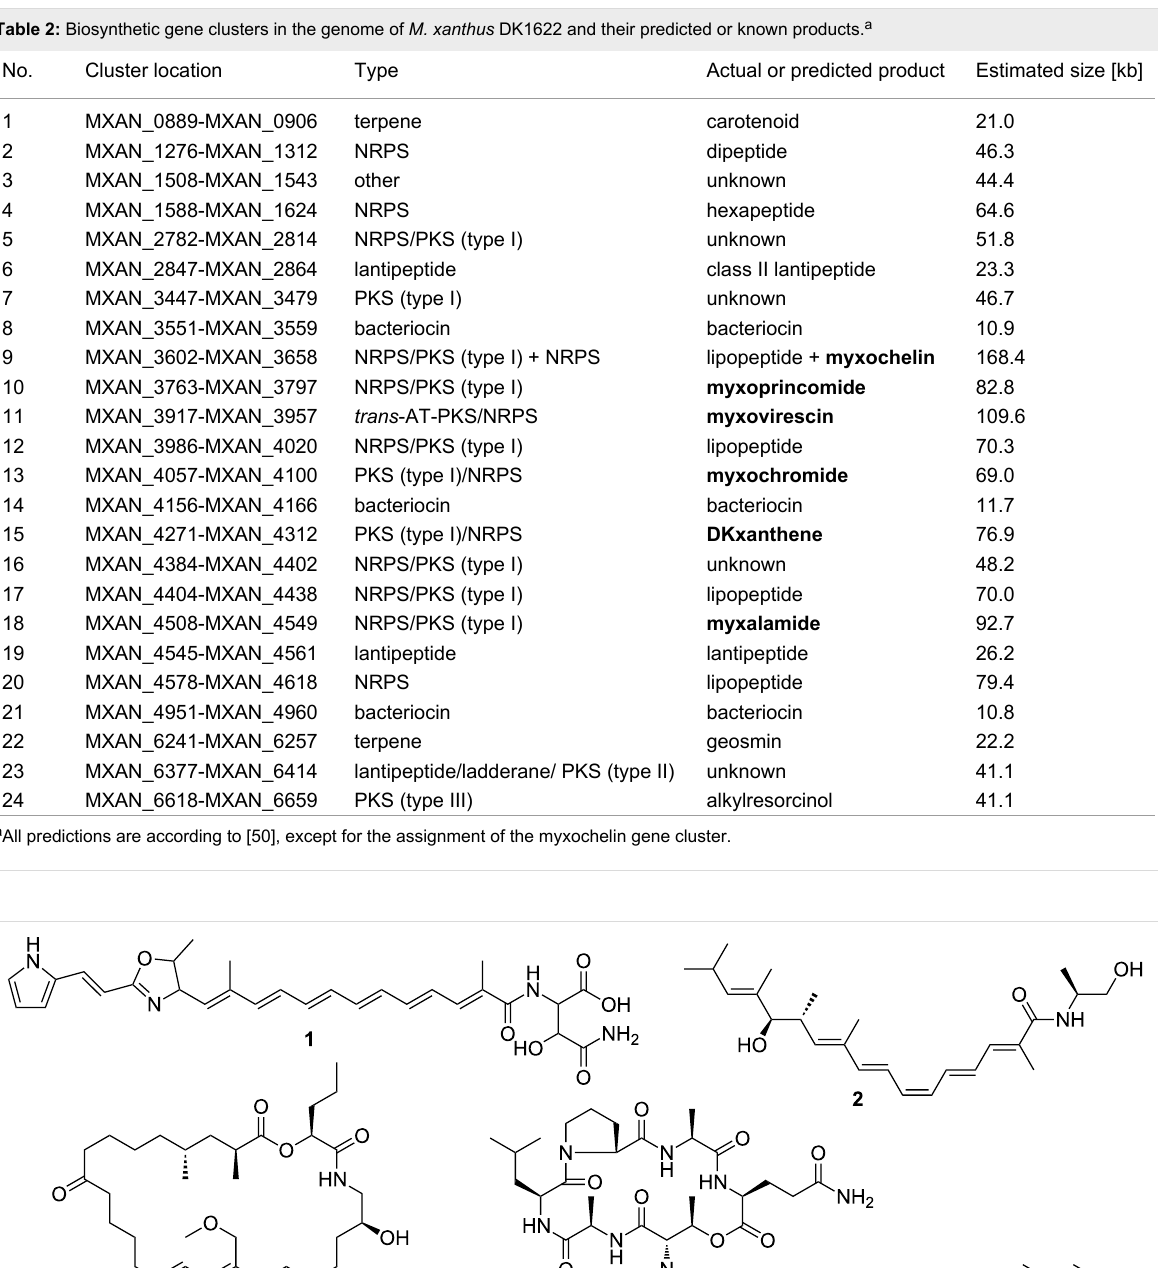
Table 2: Biosynthetic gene clusters in the genome of M. xanthus DK1622 and their predicted or known products. a